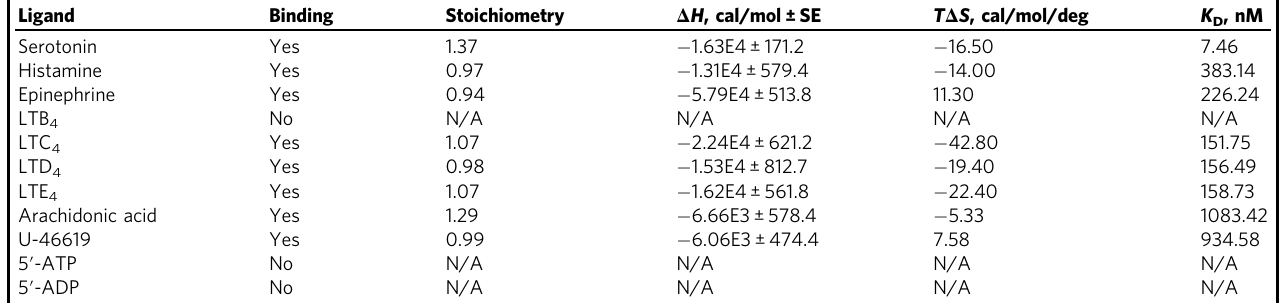
Table 2 Thermodynamic parameters of CxD7L2 protein by ITC.